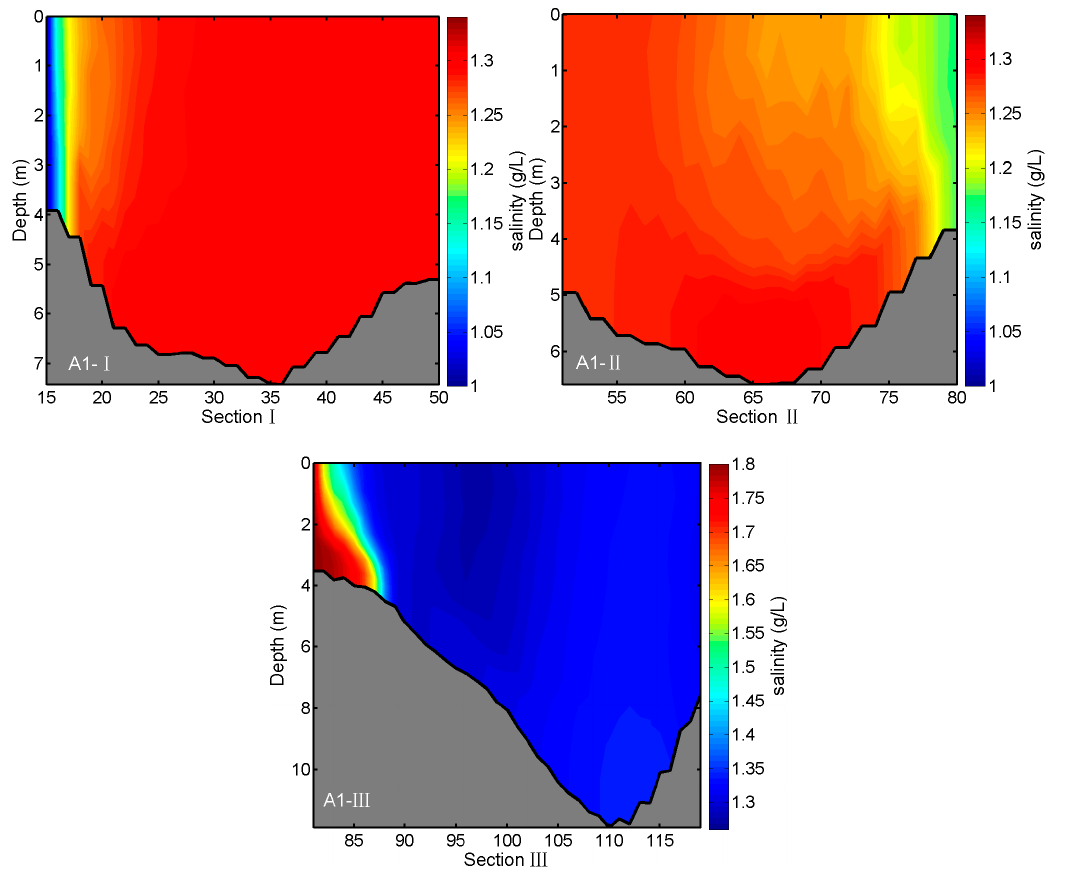
Figure 9. The three sections of Sec.I, Sec.II, and Sec.III were selected to show salinity changes in the sensitivity experiments. The arrows show the direction of the sections.